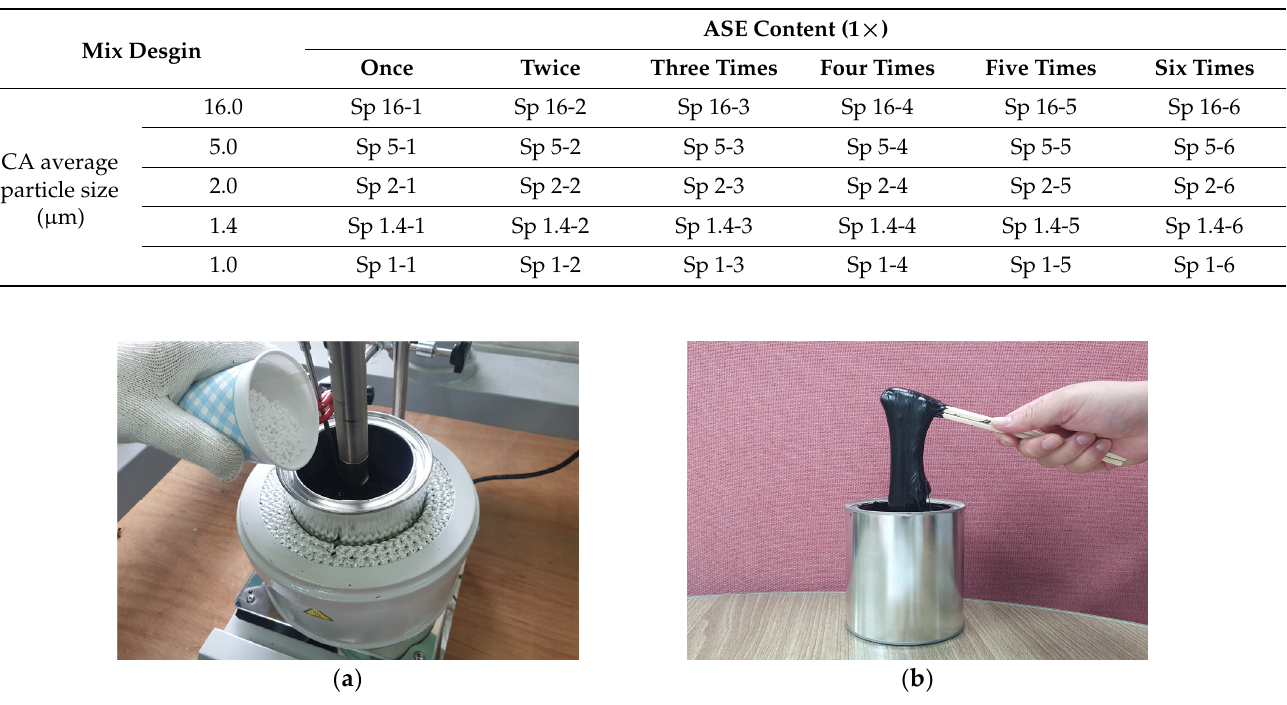
Table 3. Mix design according to ASE content and CA particle size.